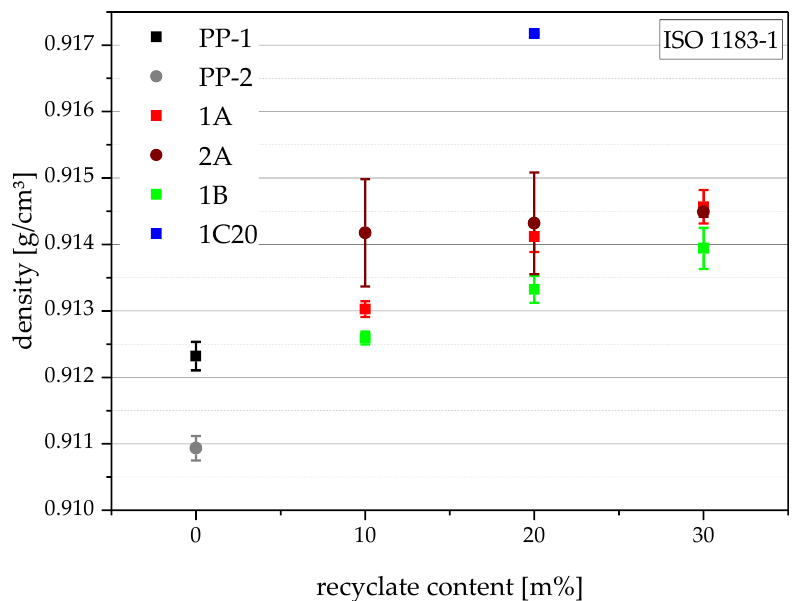
Figure 3. Graphical illustration of density values of the virgin blending partners PP-1 and PP-2 (as 0 m% recyclate content data points) and all compounds. The vertical bars show the sample standard deviations.